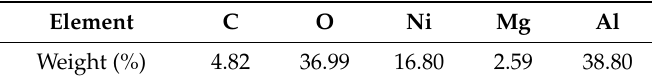
Table 5. Elemental composition of fresh 20 wt% Ni-Mg-Al catalyst determined by scanning electron microscopy–energy-dispersive X-ray spectroscopy.